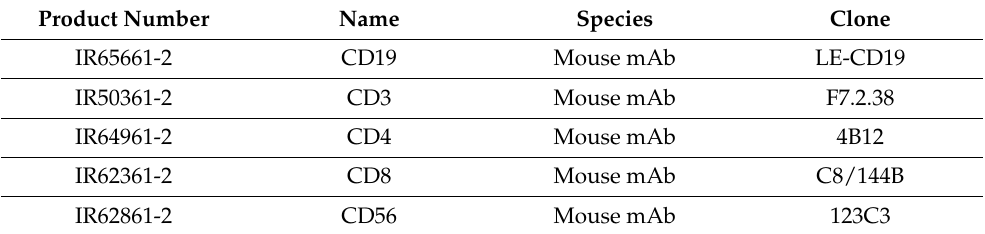
Table legend: mAB—monoclonal antibody.